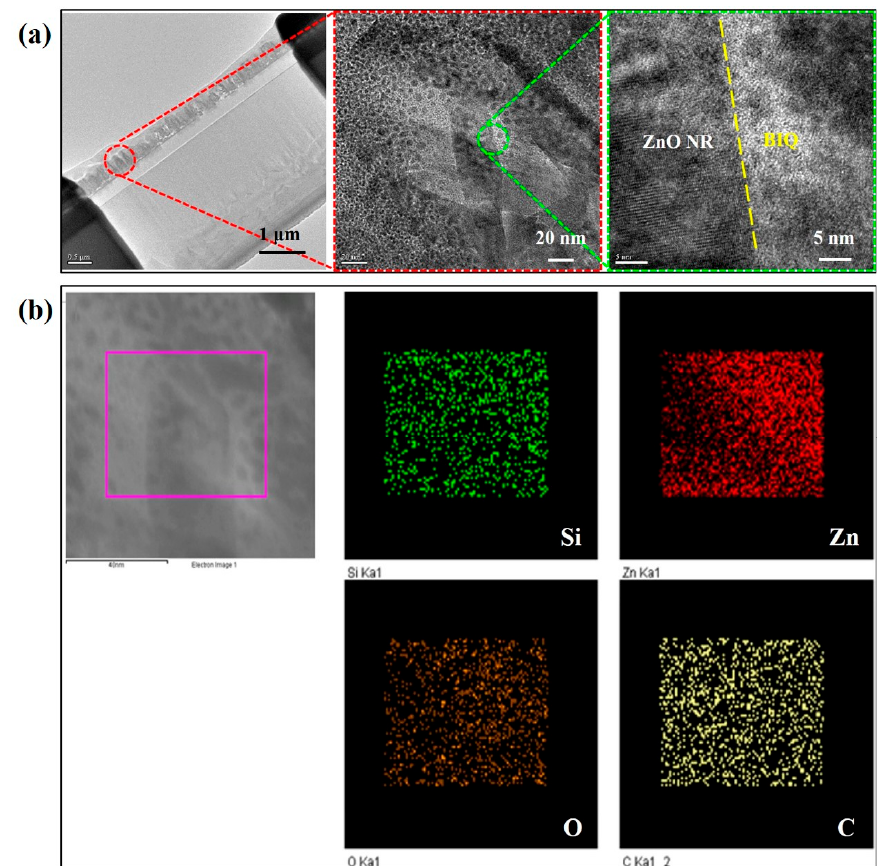
Figure 4. ( a ) The TEM images of BIQ/ZnO NRs. ( b ) The TEM image with Si, Zn, O, and C element mapping.